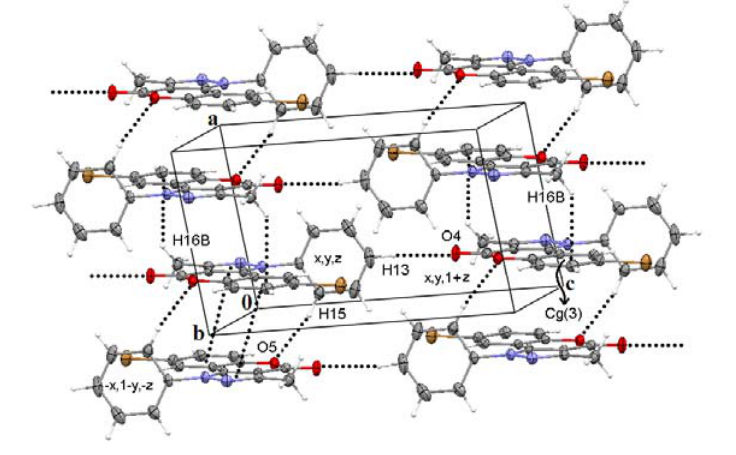
Figure 3. Intermolecular interactions for molecule 2c in the ac plane. C(12) chain motif is observed through the participation of C15 ― H15···O5 and C16 ― H16B··· Cg(3) contacts running along the direction of the a